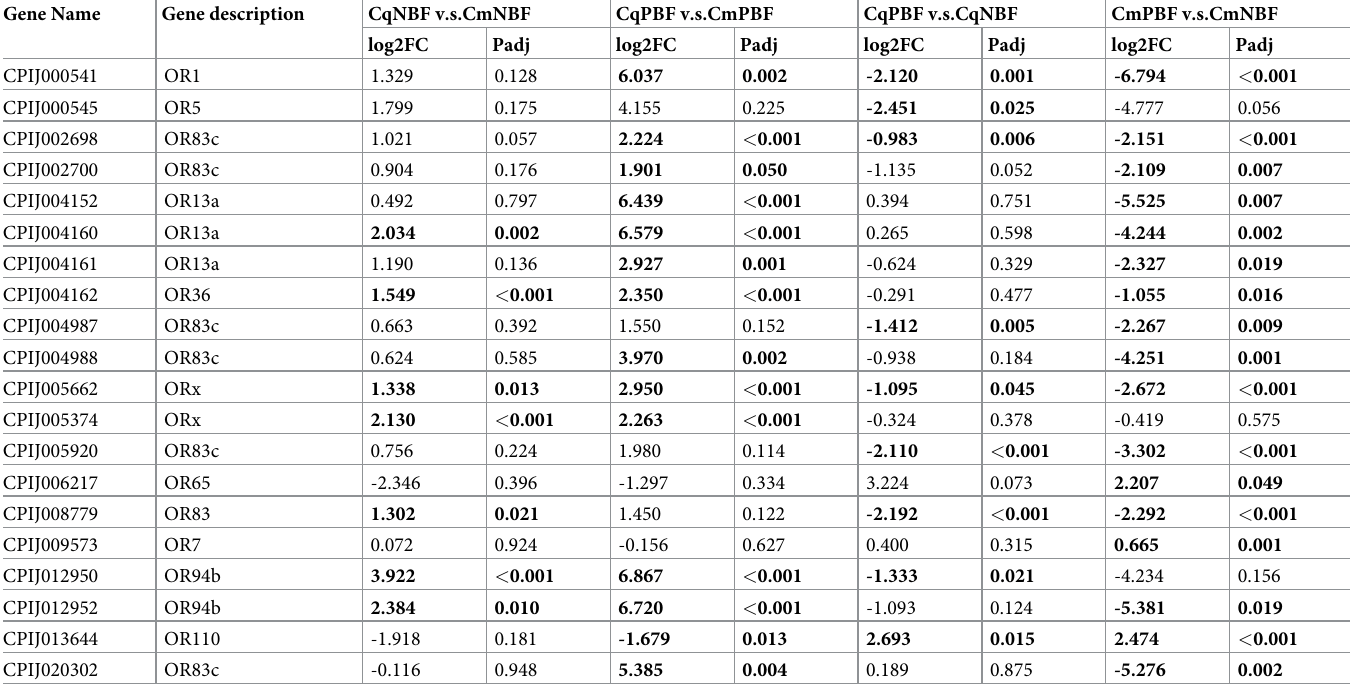
Fig 2. Venn diagrams of significantly differentially expressed OBP genes. Fig 2A: OBP genes intersections among 4 groups. Cq is short for Culex quinquefasciatus , and Cm is short for Culex molestus . NBF stands for non-blood-feeding, PBF stands for post-blood-feeding. Fig 2B: significantly differentially expressed OBP genes intersections between two subspecies before blood feeding. On the basis of the traditional venn diagram, we divided the overlapping Olive-shaped region into 3 sections “up, no-diff and down”. The X in “up” section means there were X genes significantly up-regulated when the two groups were compared. For example, there were 53(7+44+2) genes both expressed in CqNBF and CmNBF, in which 7 genes were significantly up-regulated, 2 genes down-regulated and 44 genes with no difference in expression level; Fig 2C: significantly differentially expressed OBP genes intersections between two subspecies after blood feeding; Fig 2D: significantly differentially expressed OBP genes intersections of Cx . pipiens quinquefasciatus before and after blood feeding; Fi g 2E: significantly differentially expressed OBP genes intersections of Cx . pipiens molestus before and after blood feeding. https://doi.org/10.1371/journal.pntd.0010204.g002 Table 2. Significantly expressed ORs among the four compared